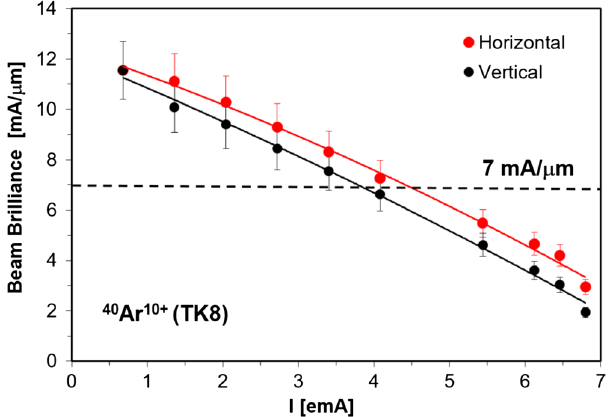
beam emittance and corresponding beam intensity measurements at the end of the transfer line (TK8) to the SIS18; FAIR requirement (A = Z ¼ 4 ; I ¼ 7 emA, horizontal emittance ¼ 1 mm ×